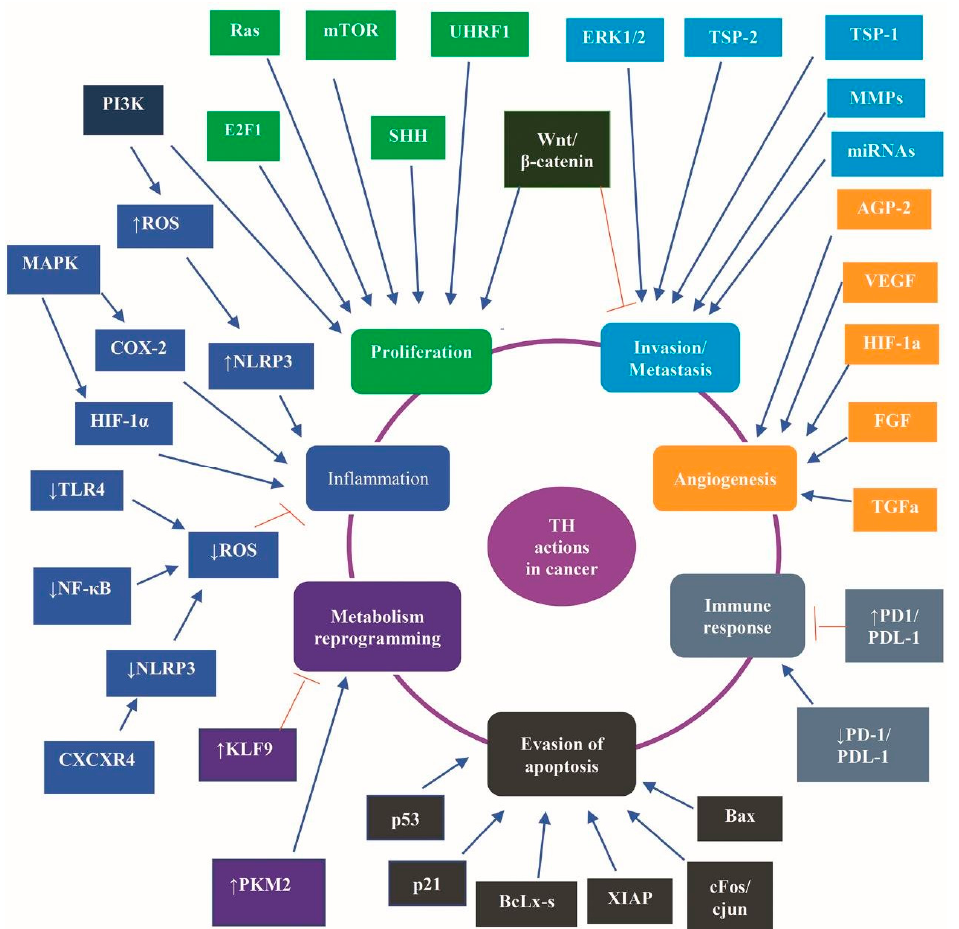
Figure 2. The contribution of TH to cancer hallmarks and the major involved signaling pathways. TH contributes to all the properties of cancer cells known as hallmarks of cancer, namely, to (i) proliferation, predominantly through SHH, UHRF1, mTOR, Ras, and E2F1; (ii) invasion/metastasis, predominantly through TSP-1, TSP-2, MMPs, miRNA, ERK1/2, and Wnt/ β catenin; (iii) angiogenesis, predominantly through AGP-2 FGF VEGF, HIF-1 α , and FGF; (iv) immune response, predominantly through PD-1 and PD-L1; (v) evasion of apoptosis, predominantly through BAX, p53, p21, cfos/cjun, XIAP, and BcLx-s; (vi) reprogramming of metabolism of cancer cells, predominantly through PKM2, KLF; and (vii) inflammation, predominantly through CXCR4, NF- κ B, NLRP3, ROS, TLR4, HIF-1 α , COX-2, MAPK, and PI3K. Abbreviations: AGP-2, angiopoietin 2, BAX, BcL-2 Associated X; COX-2, and cyclooxygenase 2; CXCR4, C-X-C motif chemokine receptor 4; E2F1, E2F Transcription Factor 1; ERK1/2, extracellular signal-regulated kinase 1/2; FGF, fibroblast growth factor 2; HIF-1 α , hypoxia inducible factor 1; MAPK, mitogen-activated protein kinase; miRNA, microRNA; MMPs, matrix metalloproteinases; mTOR, mammalian tar-get of rapamycin; NF- κ B, nuclear factor- κ B; NLRP3, NLR Family Pyrin Domain Containing 3; TLR4, Toll Like Receptor 4; PD-1, programmed cell death protein 1; PD-L1, PD ligand 1; PI3K, phosphatidylinositol 3-kinase; PKM2, M2 isoform of the pyruvate kinase; ROS, reactive oxygen species; SHH, sonic hedgehog; TGFa, transforming growth factor alpha; TSP, Thrombospondin; UHRF1, ubiquitin-like with PHD and ring finger domains 1; VEGF, vascular endothelial growth factor; XIAP, X-linked inhibitor of apoptosis Wnt, a fusion of the words wingless and integrated or int-1. An integrin α v β 3-mediated TH action in tumor stroma formation—a core component of tumor microenvironment—has been reported in a subcutaneous HCC xenograft model. T3 or T4 increased the recruitment and the invasion of mesenchymal stem cells (MSCs)